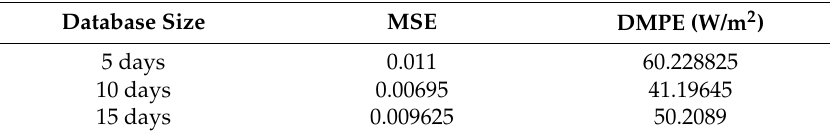
Table 2. Choice of the test and training size of the Table 3. Choice of the time average of the database.